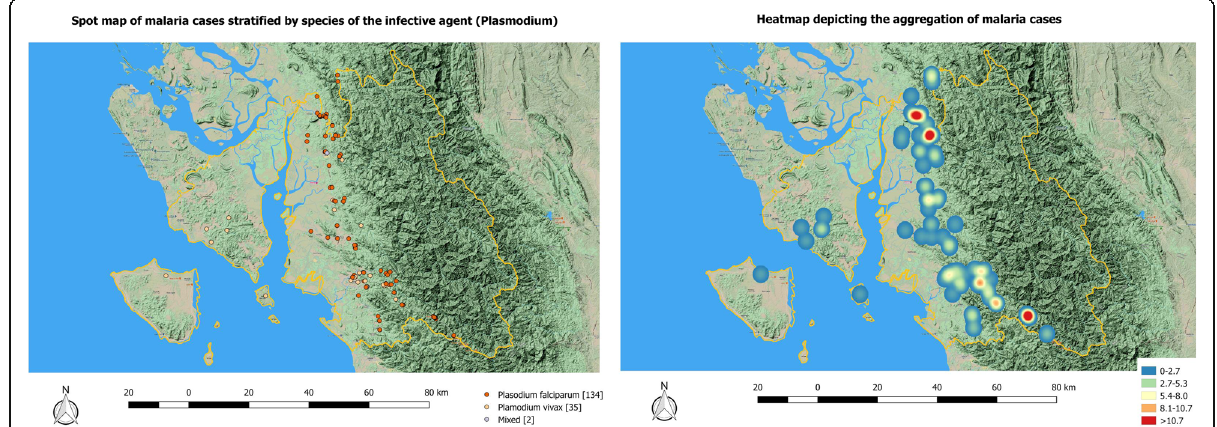
Fig. 3 Spot map (stratified by type of species) and heat map of malaria